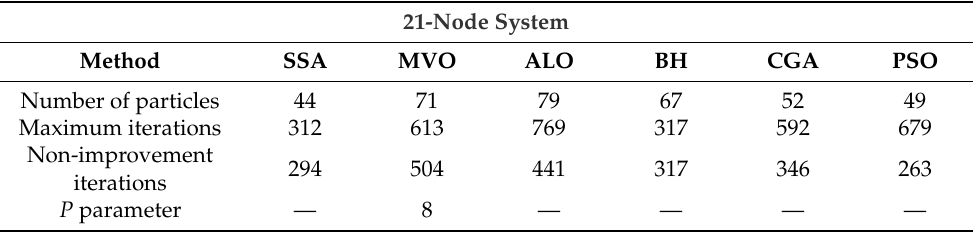
Table 2. Parameters of the continuous methods employed here in the master stage for the 21- node system.